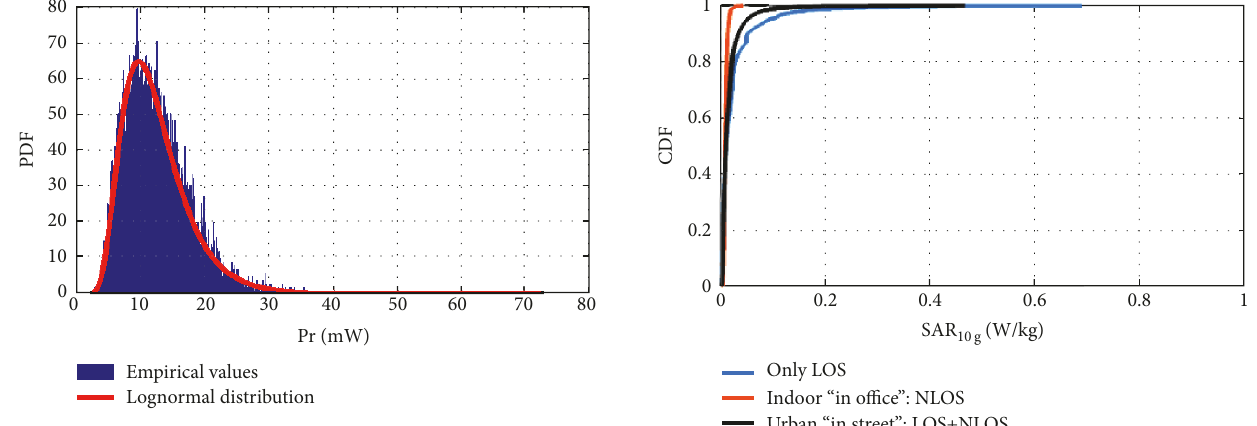
Figure 9: SAR 10 induced by the tablet at 1940 g